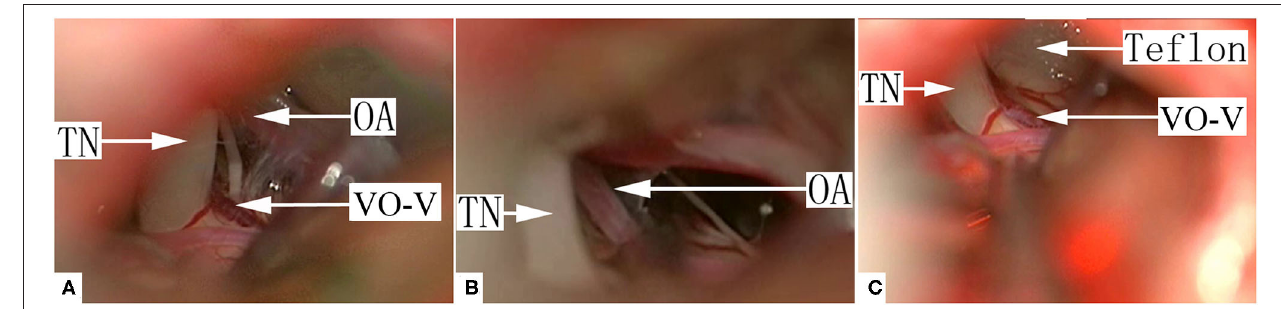
FIGURE 6 | A representative case of group III, type C VO-VREZ. (A) A definitive offending artery was identified. The small VO-VREZ ran through the trigeminal nerve root. (B) The offending artery was dissected. (C) The nerve root was decompressed from the artery with shredded Teflon interposition. The VO-VREZ was left alone. TN, trigeminal nerve; OA, offending artery; VO-V, venous offending on the ventral side of root entrance/exit zone; Teflon, shredded Teflon interposition.